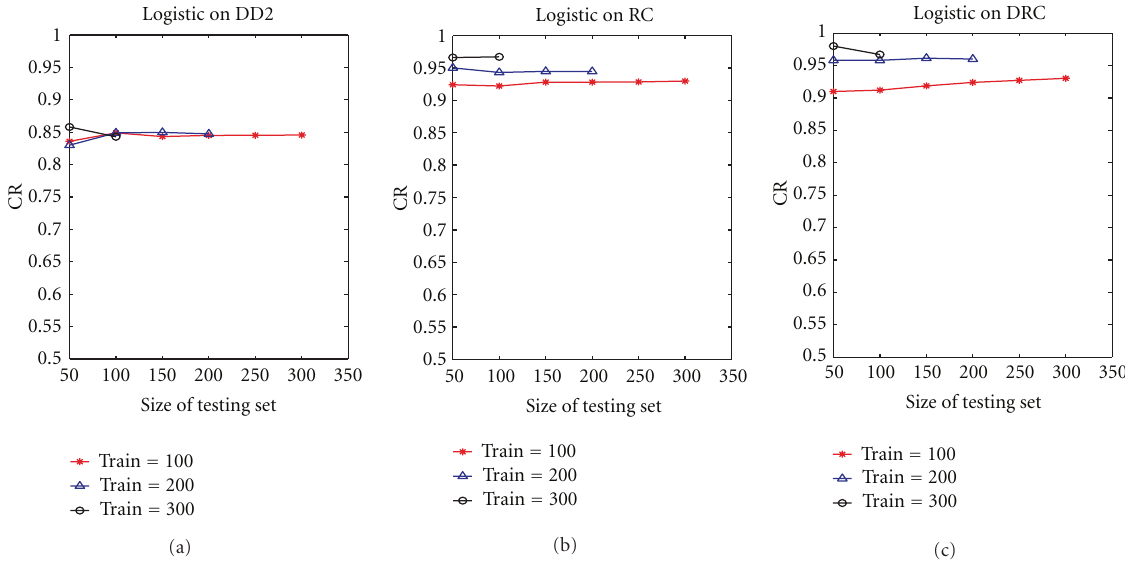
Figure 4: Variation of classification rate (CR) with size of testing set using the proposed descriptors DD2 (a), RC (b), and DRC (c). Results are shown for the average over 10 runs, using logistic regression as the classifier.